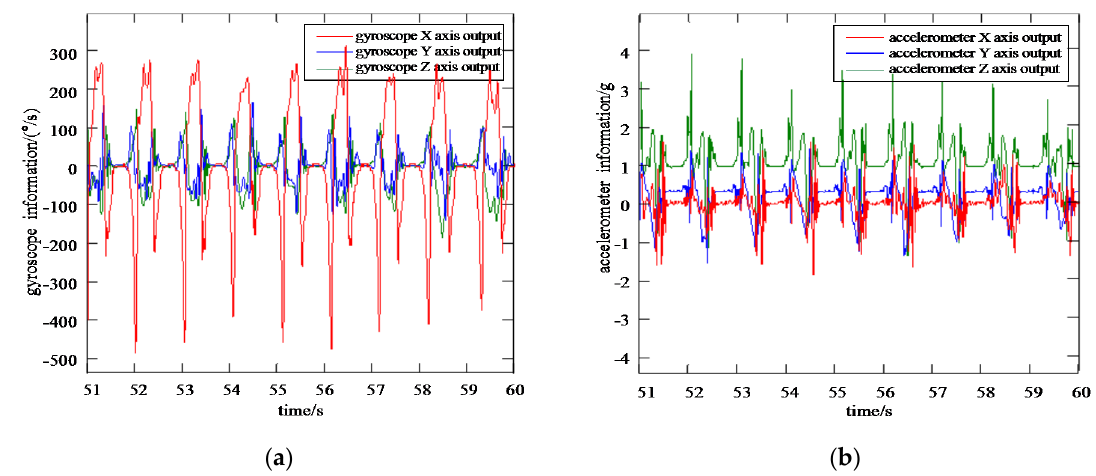
Figure 5. Gyroscope and accelerometer information from pedestrian foot ( a ) Gyroscope information from pedestrian foot; ( b )Accelerometer information from pedestrian foot.